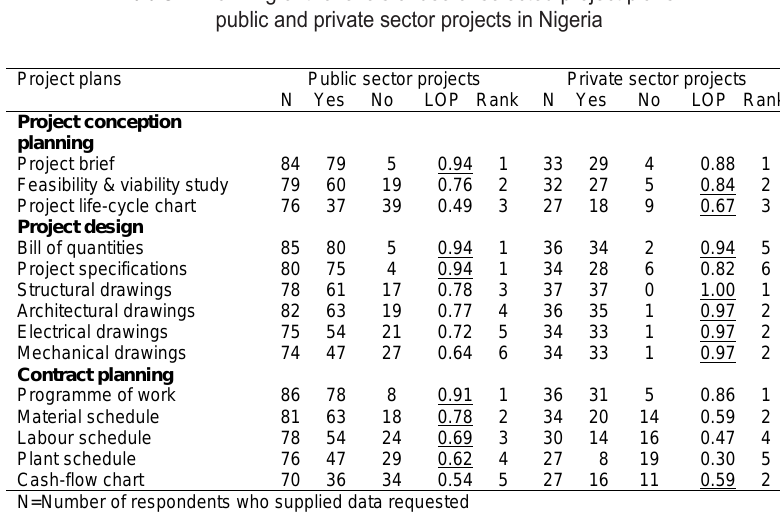
Table 1: Ranking of the levels of use of selected project plans